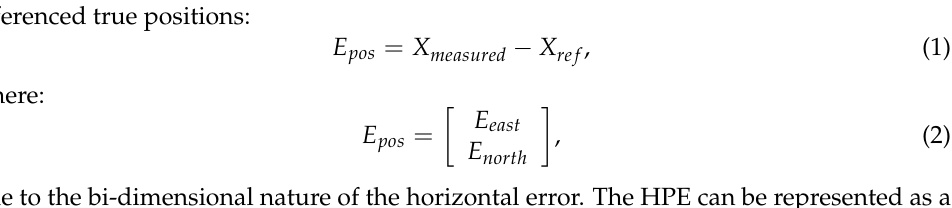
due to the bi-dimensional nature of the horizontal error. The HPE can be represented as